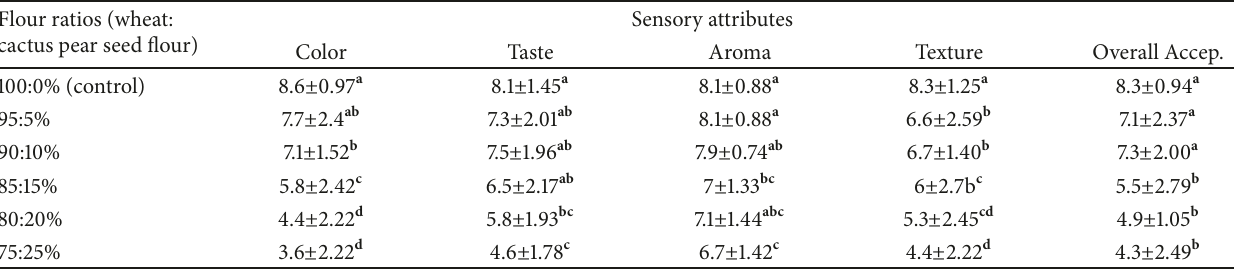
Table 5: Sensory attributes of cactus pear seed and wheat flour